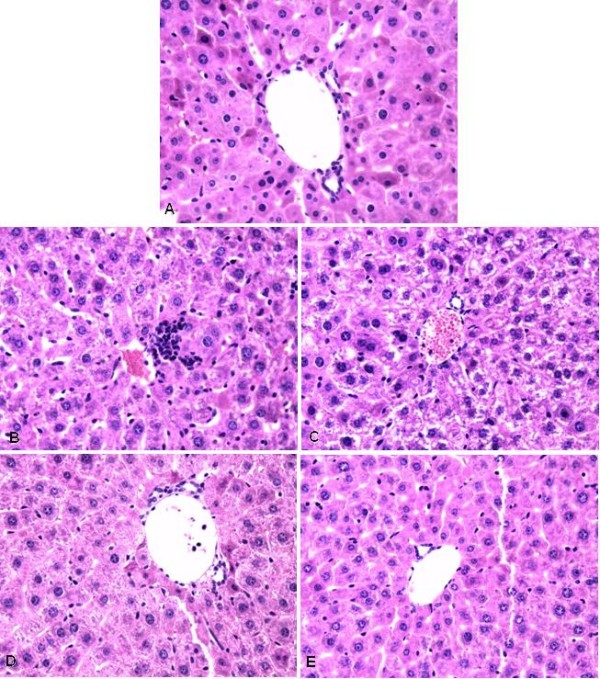
Histological examination of regenerating mouse livers following 50% PH. Fig.1(A) Liver histology slide of sham-operation group (HE staining 400×) showing clear hepatic lobule, radial liver cell cord, and clear hepatic sinusoid; Fig.1(B) Liver histology slide of 50% PH group 1 day after operation (HE staining 400×) showing cloudy swelling of some hepatocytes with focal piecemeal necrosis, and hepatocytes with multiple and enlarged nuclei started to appear. Fig.1(C) Liver histology slide of 50% PH group 3 days after operation (HE staining 400×) showing the majority of hepatocytes with double, multiple nuclei or single enlarged nuclei, prominent nucleoli, and cytoplasmic acidophilic bodies; Fig.1(D) Liver histology slide of 50% PH group 13 days after operation (HE staining 400×) showing double or enlarged nuclei but less prominent acidophilic bodies in most hepatocytes; Fig.1(E) Liver histology slide of 50% PH group 25 days after operation (HE staining 400×) showing double or enlarged nuclei still present in many hepatocytes which contain much reduced acidophilic bodies.